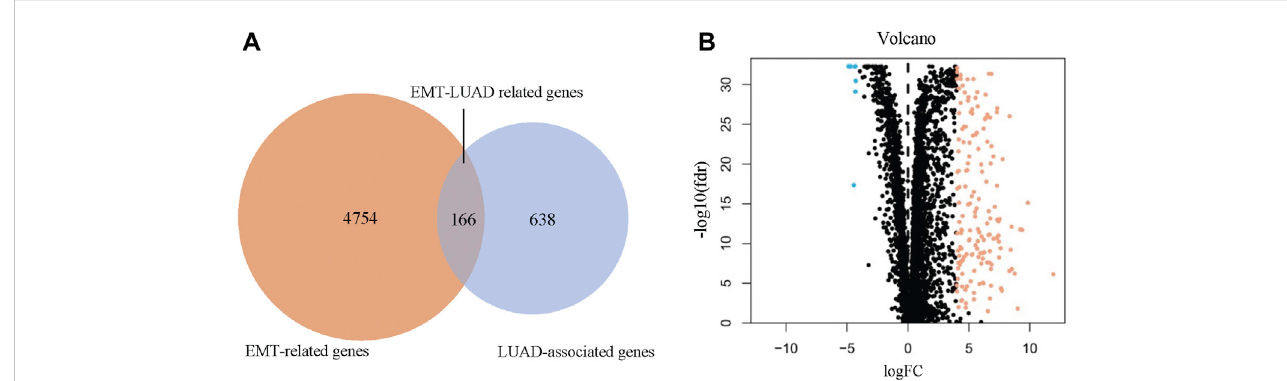
FIGURE 1 Identi fi cation of the overlapping genes between the EMT-related genes and the LUAD associated genes (EMT-LUAD related genes). (A) Venn diagram con fi rmed the EMT-LUAD related genes. (B) Volcano-plot of EMT-LUAD related genes (the blue dots represent the down-regulated genes and the orange dots represent the up-regulated